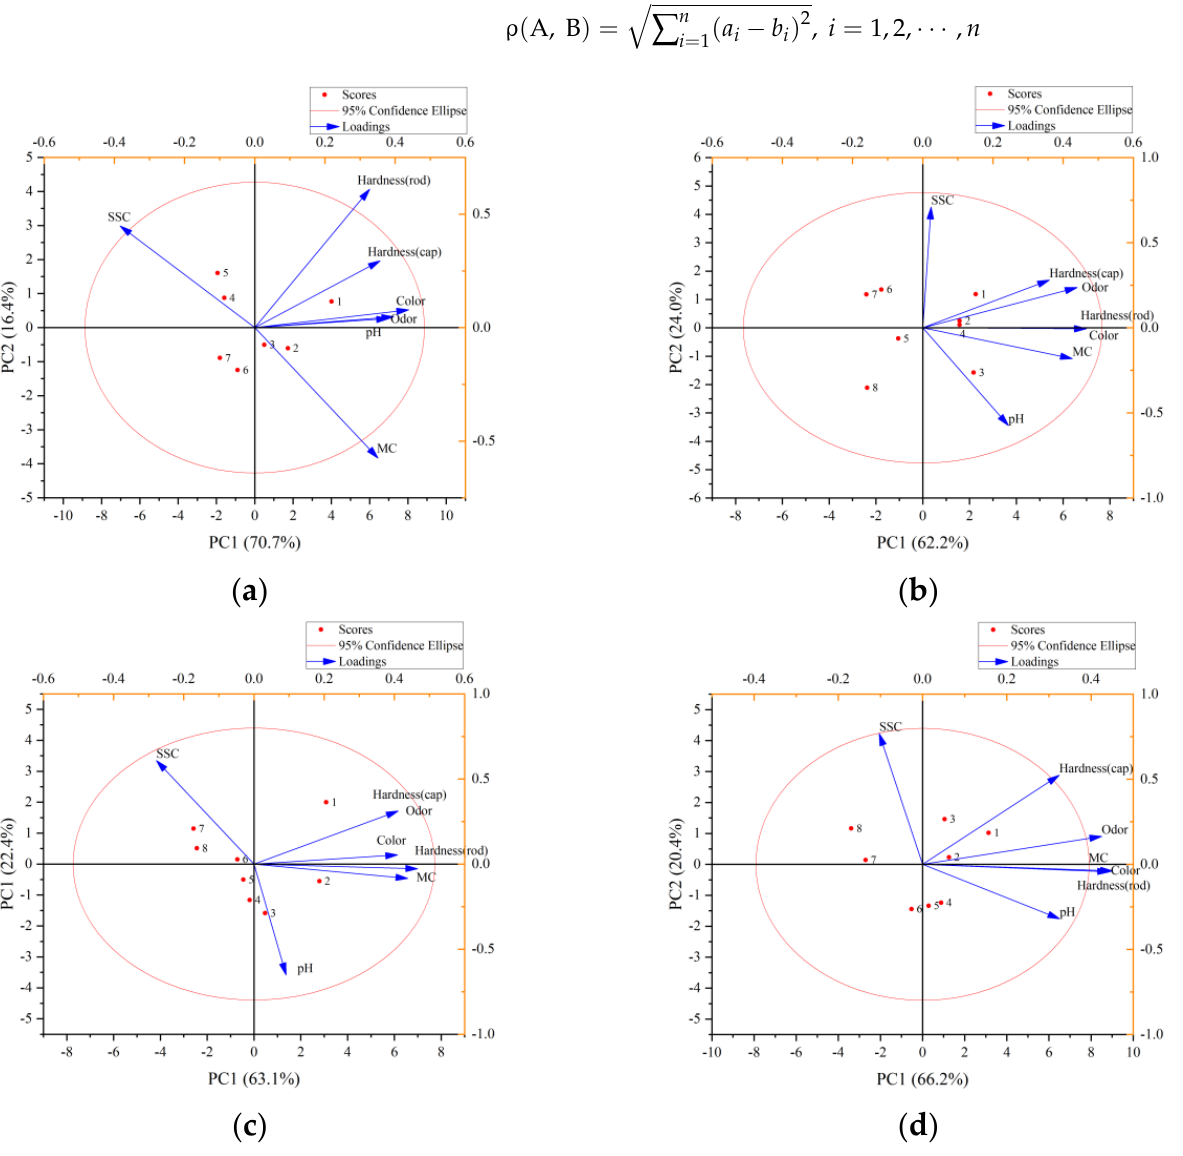
Figure 10. Cluster analysis: ( a ) refrigeration preservation packaging at 0 ◦ C; ( b ) refrigeration preservation packaging at 4 ◦ C; ( c ) modified atmosphere packaging; ( d ) preservative preservation packaging. The red ellipse represents a 95% confidence interval, which verifies the feasibility of the cluster analysis method. In this paper, the quality indicators of the matsutake were divided into two categories, namely, two cluster centroids were obtained, and finally two comprehensive indicators were obtained: cluster 1(PC1) and cluster 2(PC2); PC1 and PC2 contained most of the information of the original data. It is easy to see that the SSC has a strong positive correlation with PC2, the MC and pH have a negative correlation with PC2. The hardness (cap, rod), color and odor have a strong positive correlation with PC1. Therefore, the seven quality indicators were divided into physicochemical